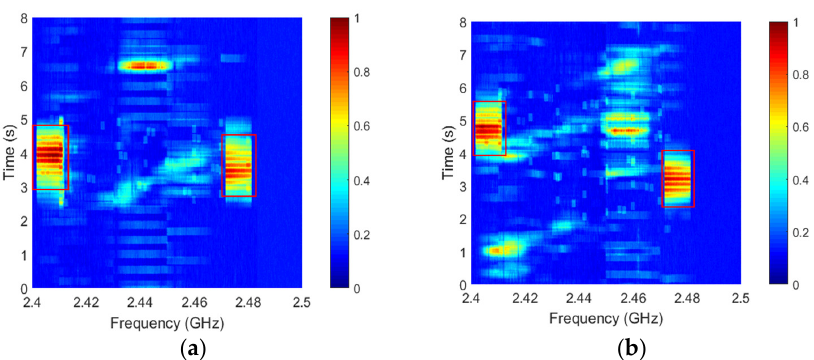
Figure 24. Normalized time–frequency diagrams after filtering for two UAVs indoors at distances of ( a ) 5 m and ( b ) 10 m.